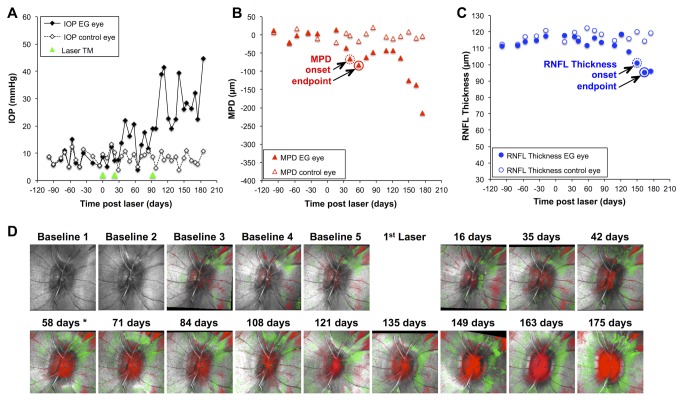
Longitudinal comparison of optic nerve head surface topography and peripapillary retinal nerve fiber layer (RNFL) thickness in a single representative animal.(A) IOP versus time; green arrowheads indicate dates of laser photocoagulation to the trabecular meshwork (Laser TM) in the eye with experimental glaucoma (EG, filled diamonds) and fellow control eye (open diamonds). (B) Optic nerve head surface topography parameter “mean position of the disc” (MPD) versus time in the EG eye (filled triangles) and fellow control eye (open triangles). (C) Peripapillary RNFL thickness versus time in the EG eye (filled circles) and fellow control eye (open circles). The data points indicated by closed circles in 1B and 1C represent the endpoint for MPD and RNFL thickness, respectively, determined by the criterion of two sequential observations below the measurement noise limit; the data points indicated by broken circles represent the “onset” determined by the same criterion. (D) Topographic Change Analysis (TCA) maps are shown for the EG eye; red superpixels represent significant posterior deformation as compared with the first baseline, green superpixels represent significant anterior deformation. Asterisk indicates date of MPD endpoint shown in 1B, 58 days after first laser.